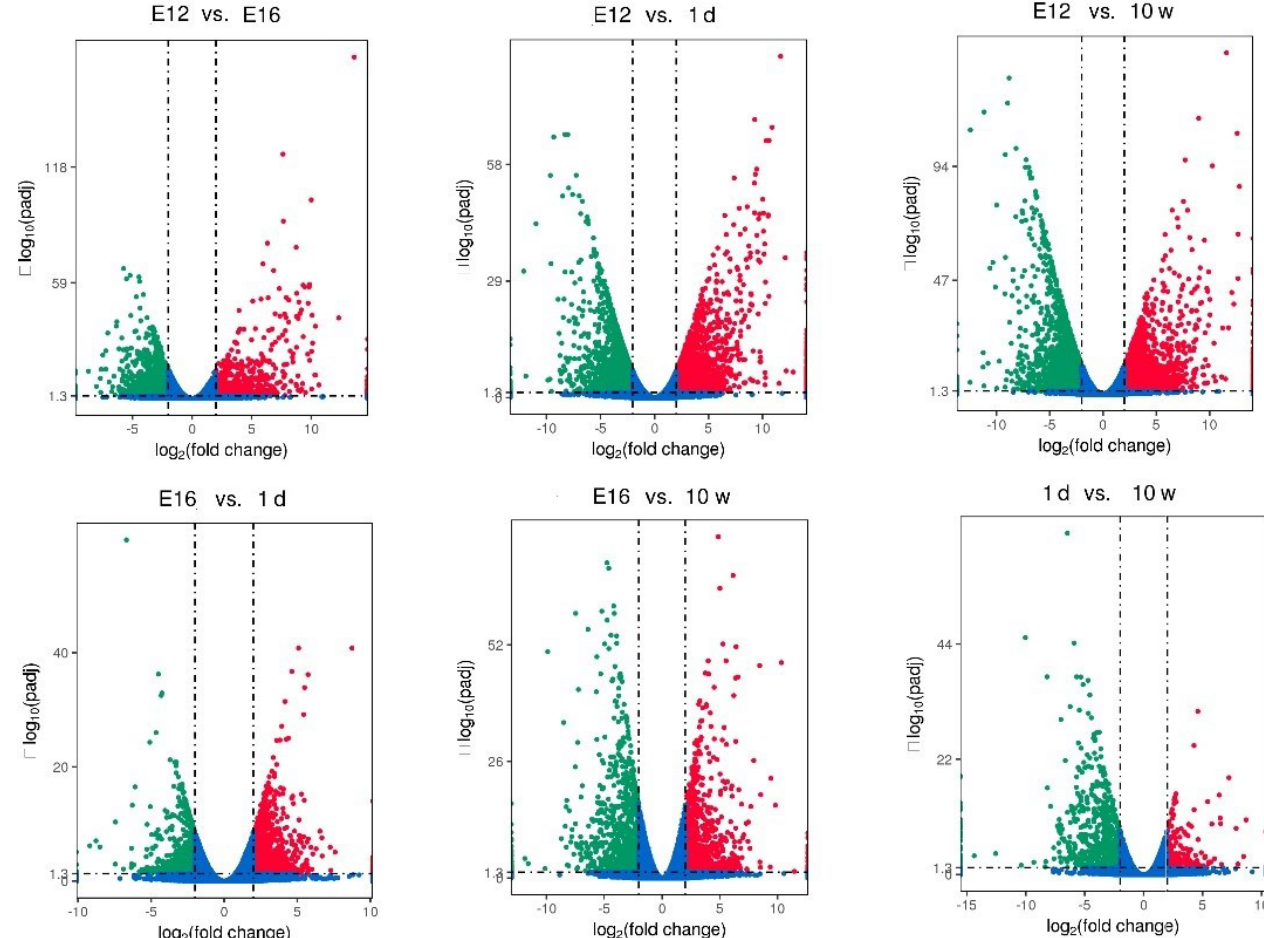
Figure 1. Differentially expressed genes identified between different groups of chickens.